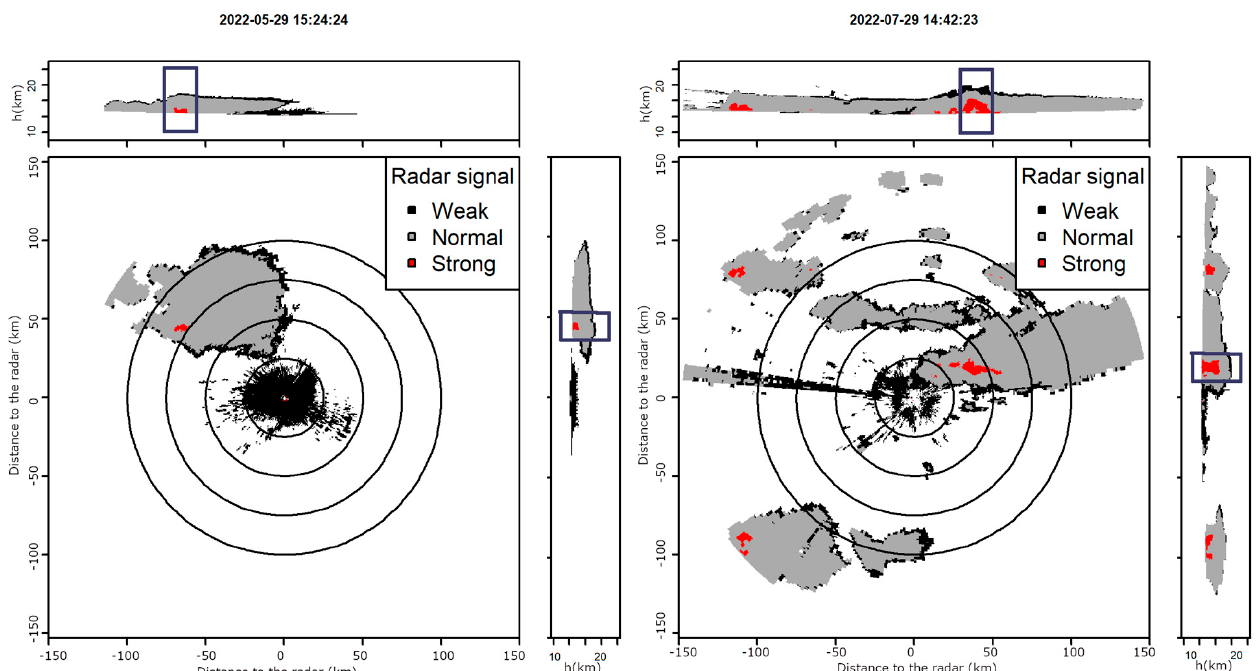
Figure 7. MAX fields of the same cases as Figure 4 ( left : PDA radar, 29 May 2022; right : CDV radar, 29 July 2022). The TBSS signature is marked with a rectangle.